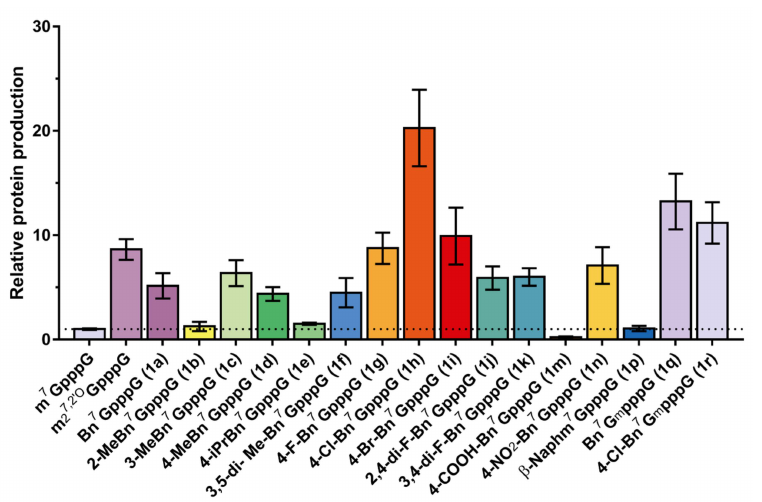
Figure 6. The influence of N7-benzylated dinucleotide 5 (cid:48) cap analogues on the translational properties of HPLC-purified IVT mRNA. Total protein produced over 72 h by A549 cells transfected with HPLC- purified, capped mRNAs. Data shown are mean cumulative protein expression values from triplicate experiments (each consisting of three independent transfections; Figure S4). Bars are mean value normalized to m 7 GpppG RNA ±